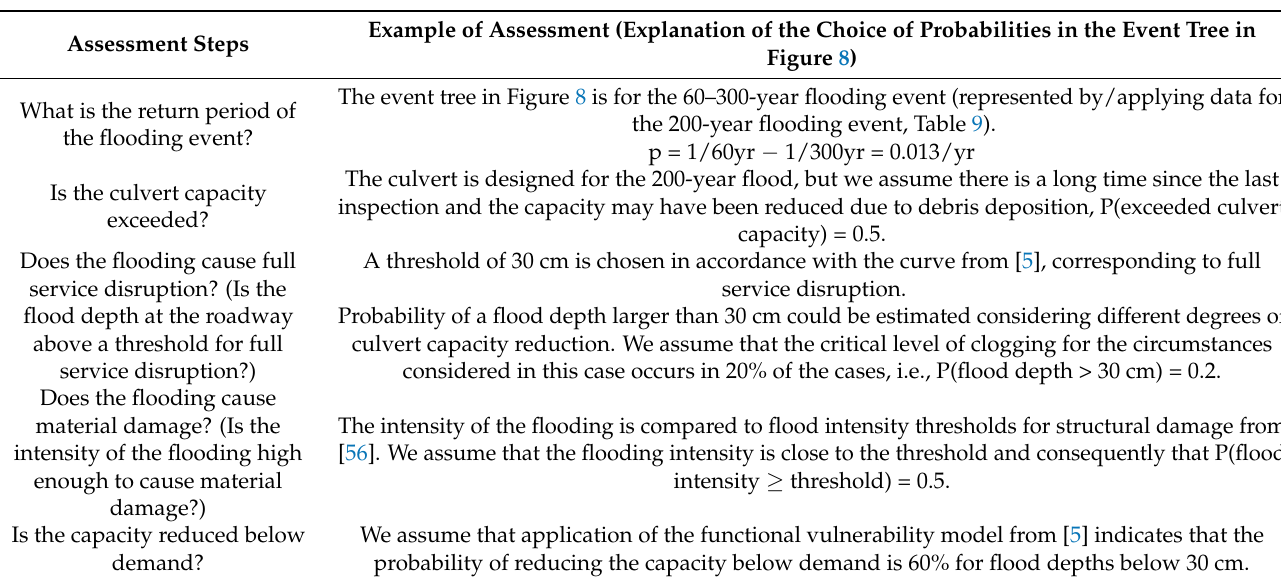
Table 8. Definition of events and considerations for assessment of event probabilities.